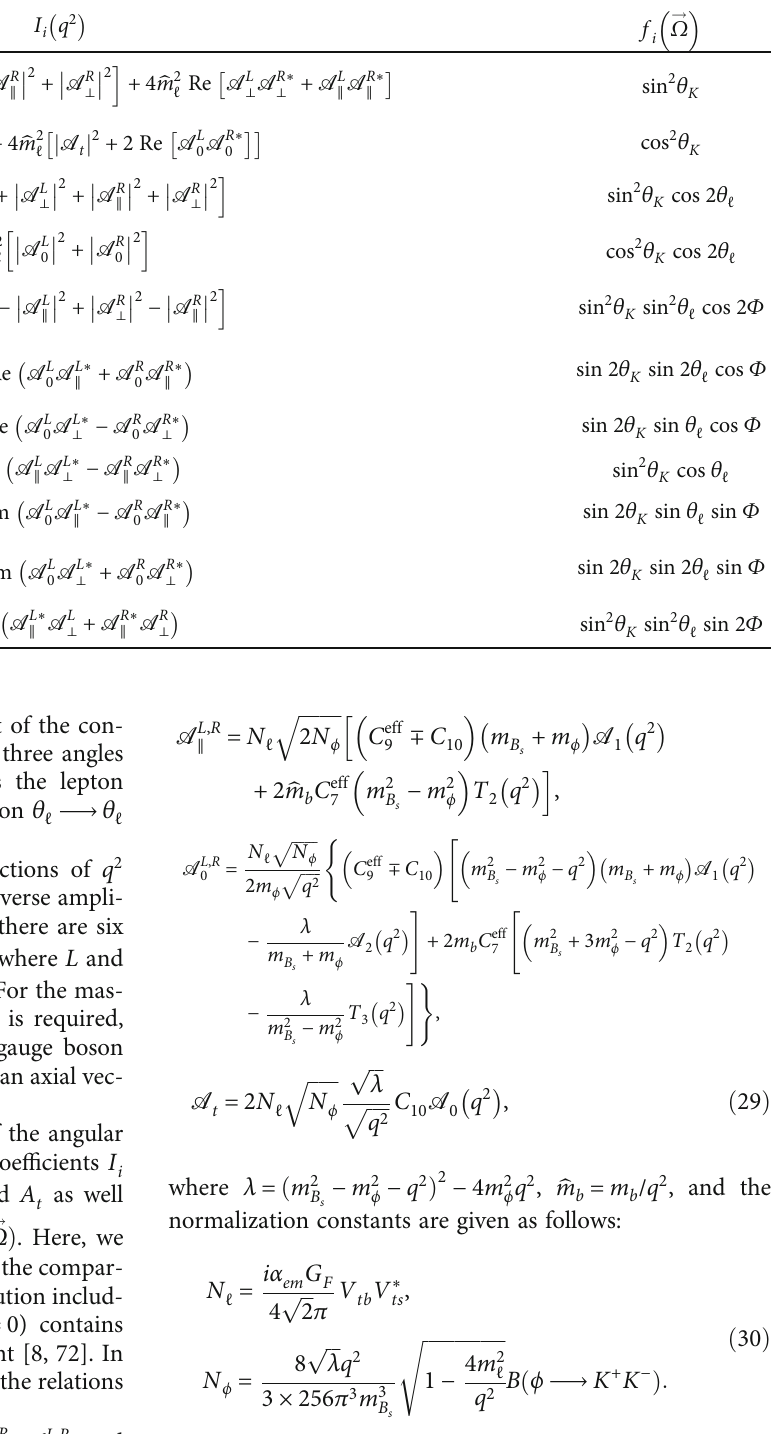
Table 1: The explicit expressions of the angular coe ffi cients I